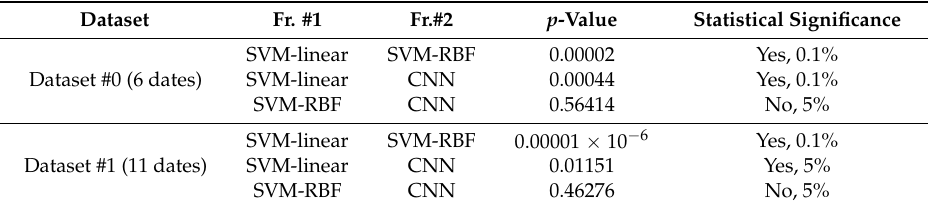
Table 4. Statistical significance of the compared classification